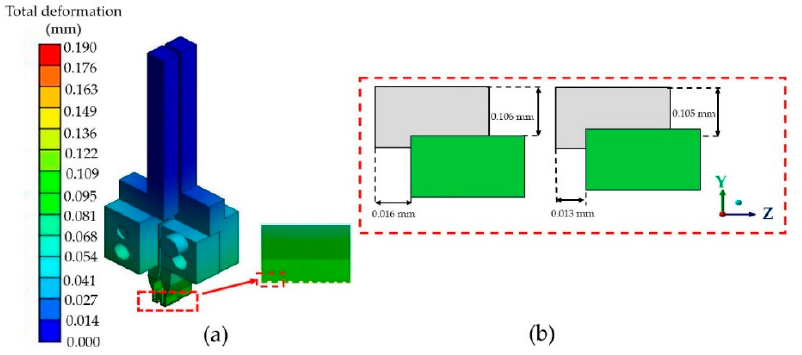
Figure 17. Total deformation from the structural simulation for the series WT: ( a ) overview and ( b ) sketch picture focusing on connecting areas in the yz plane.